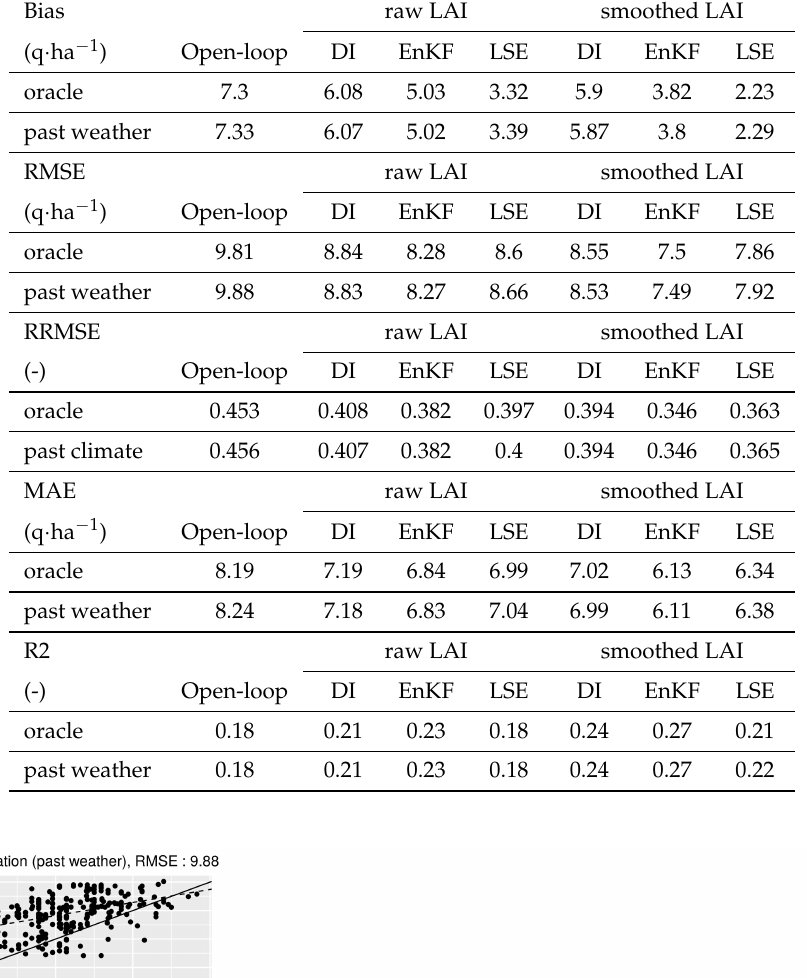
Table 4. LAI assimilation results: root mean squared error (RMSE), coefficient of determination (R2) and bias are given for the different methods (columns) and different weather series used to complete simulation (rows).